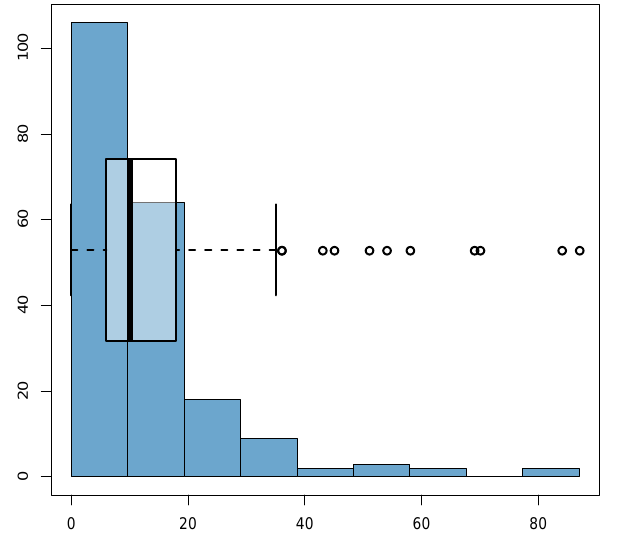
Figure 5. Boxplot and histogram of the oncological check-ups’ durations. Axis X : check-ups’ durations in minutes. Axis Y : number of patients.